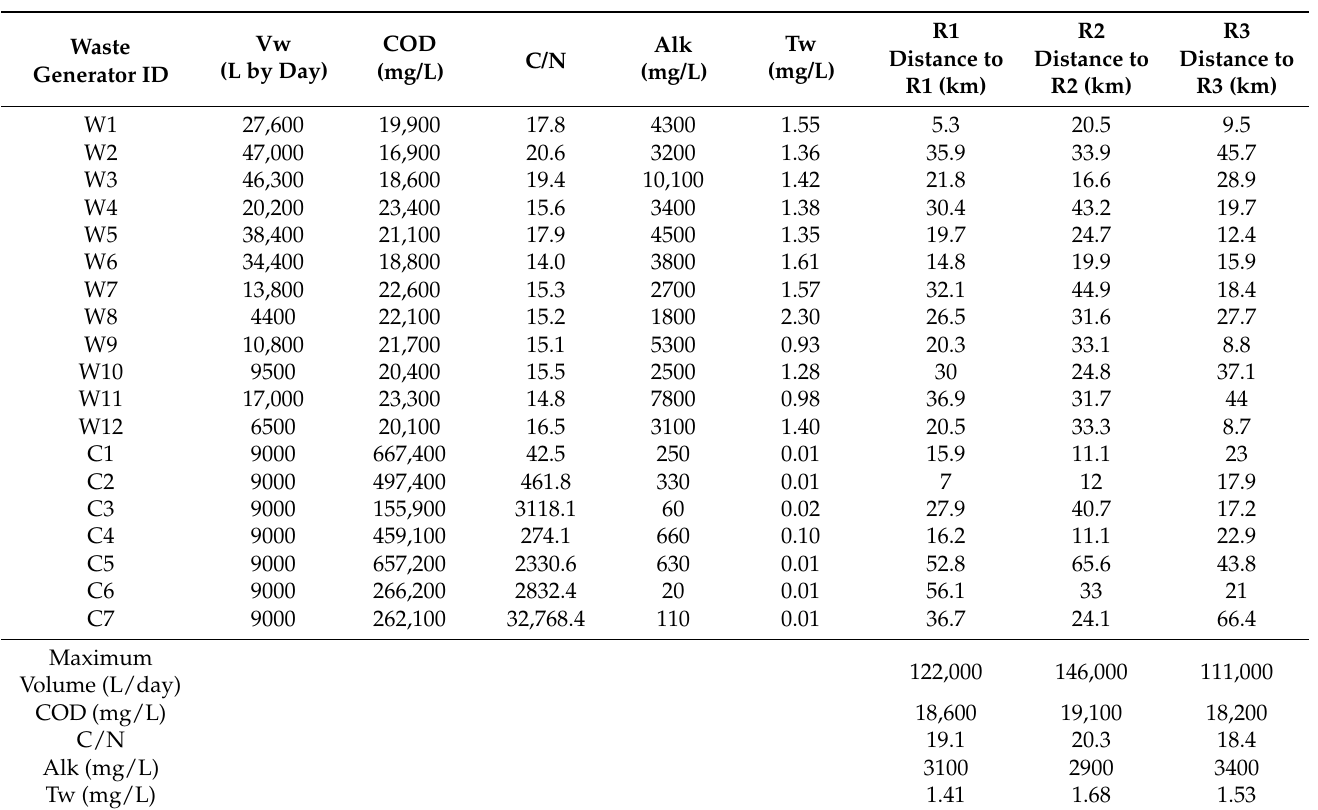
Table 3. Waste generator dataset, including distance between waste generators and receptors and characterisation of each receptor of the case study (Baseline Scenario or Scenario